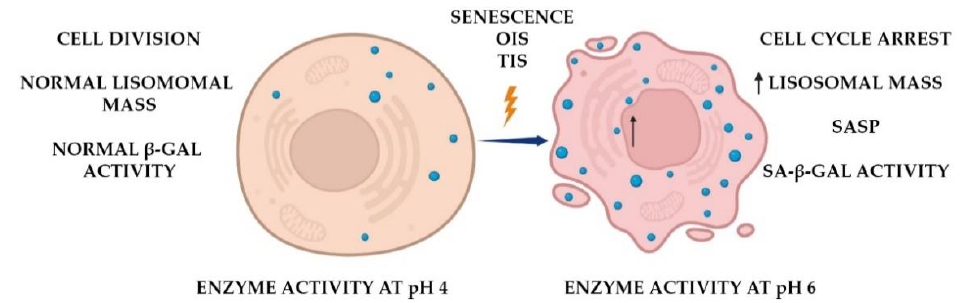
Figure 1. Biological role of senescence-associated β -galactosidase. The enzyme is active in the majority of cells at pH 4, indicating their normal state. Senescent cells accumulate pH 6 active β -galactosidase, undergo cell cycle arrest, and obtain senescence-associated secretory phenotype (SASP) overexpressing GLB1 gene (arrow).